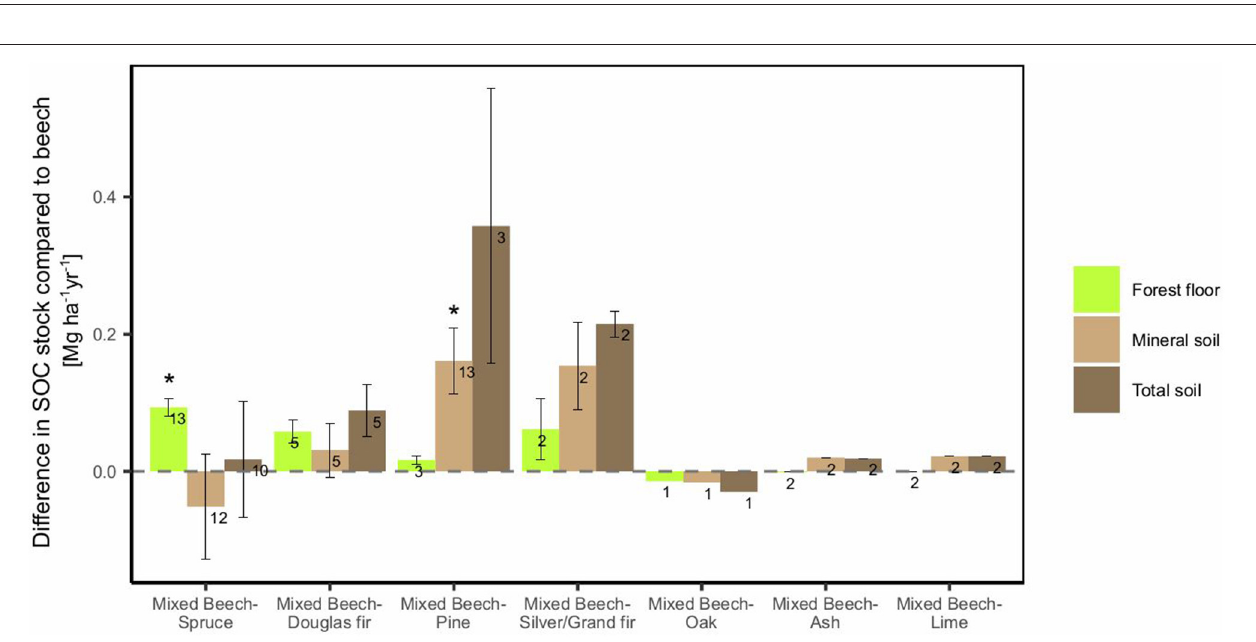
FIGURE 5 | Average absolute annual differences of SOC stocks of mixed forest stands compared to beech monocultures. Numbers next to the bars are the number of observations. Error bars show the standard error. Asterisks indicated significant differences compared to beech monocultures. Note that in some cases the difference for the total soil is not the sum of those for the forest floor and mineral soil, since not all studies included observations for both layers.